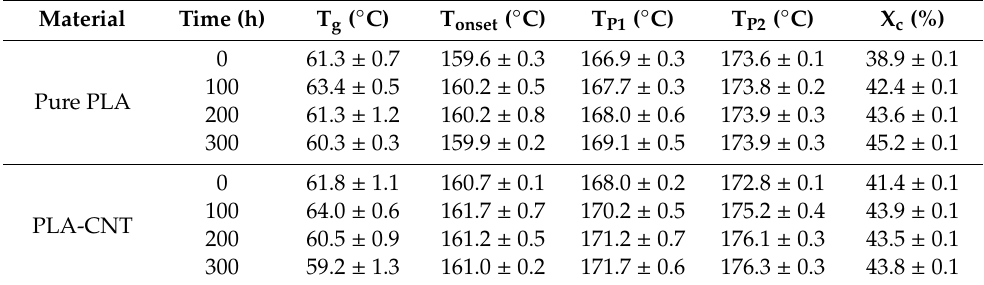
Table 1. Thermal properties of PLA and its nanocomposite before and after degradation test. Material Time (h) T g ( ◦